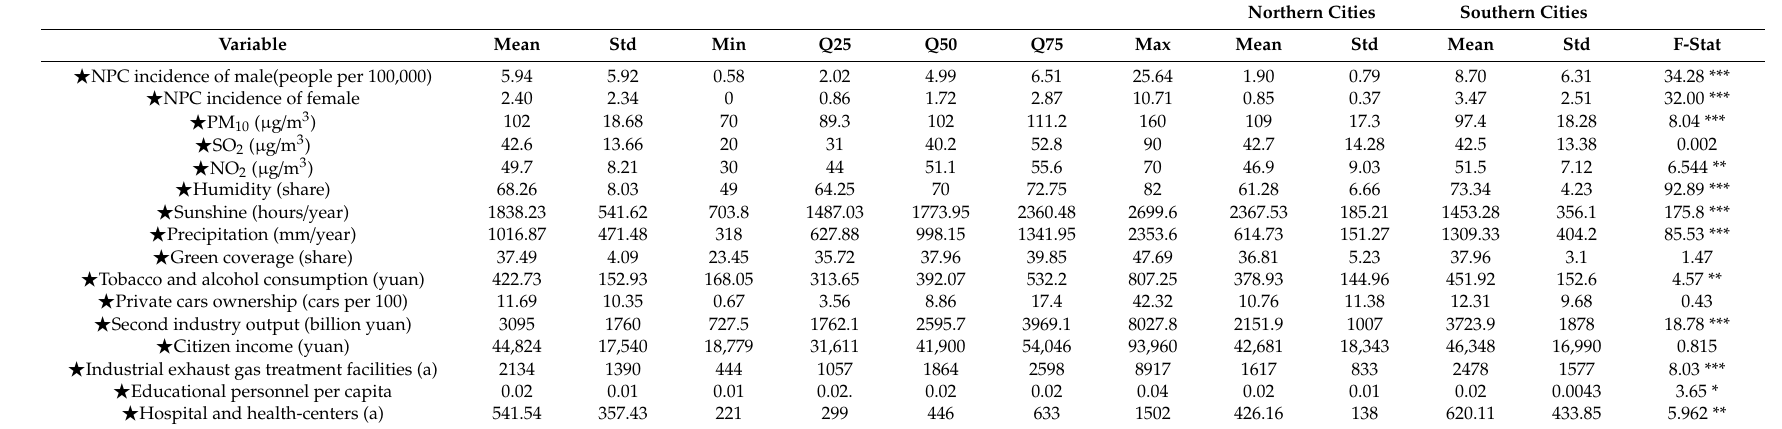
Table 1. Summary statistics of